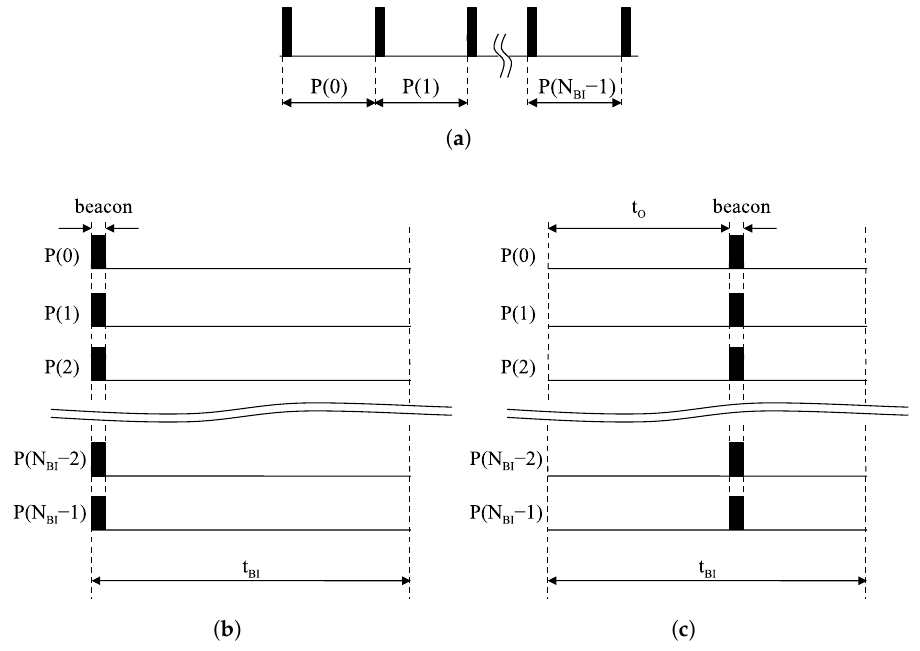
Figure 3. Beacon alignment: ( a ) Periodic beacons at an access point; ( b ) Piled beacons at an access point; ( c ) Piled beacons at a